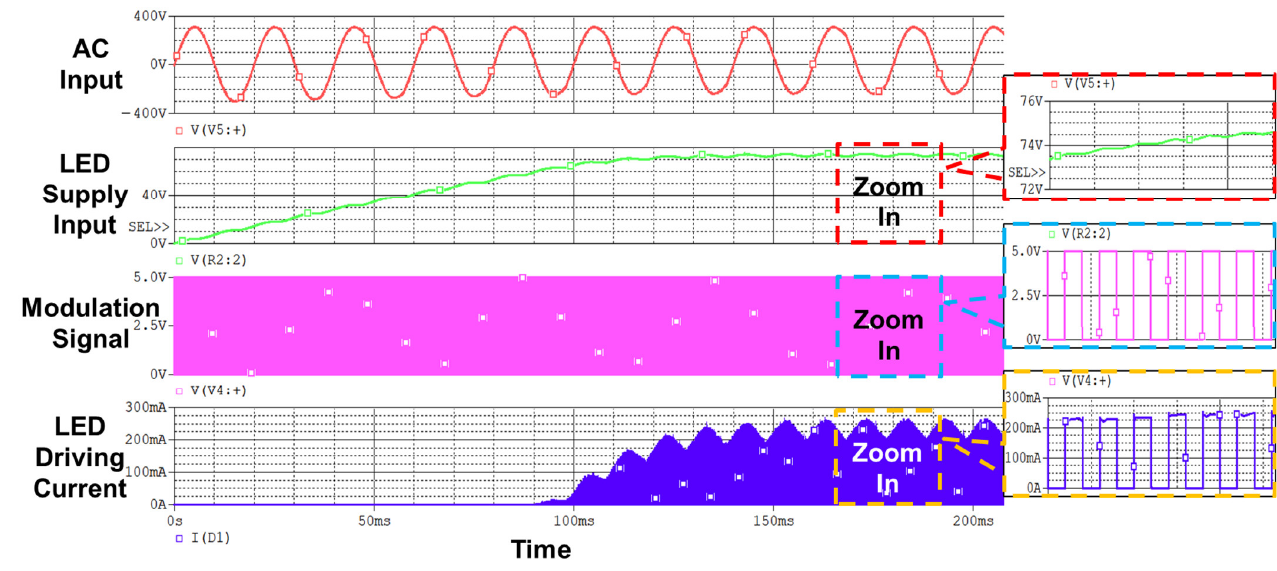
Figure 4. Simulated waveforms of designed VLC-based LED lightbulb.